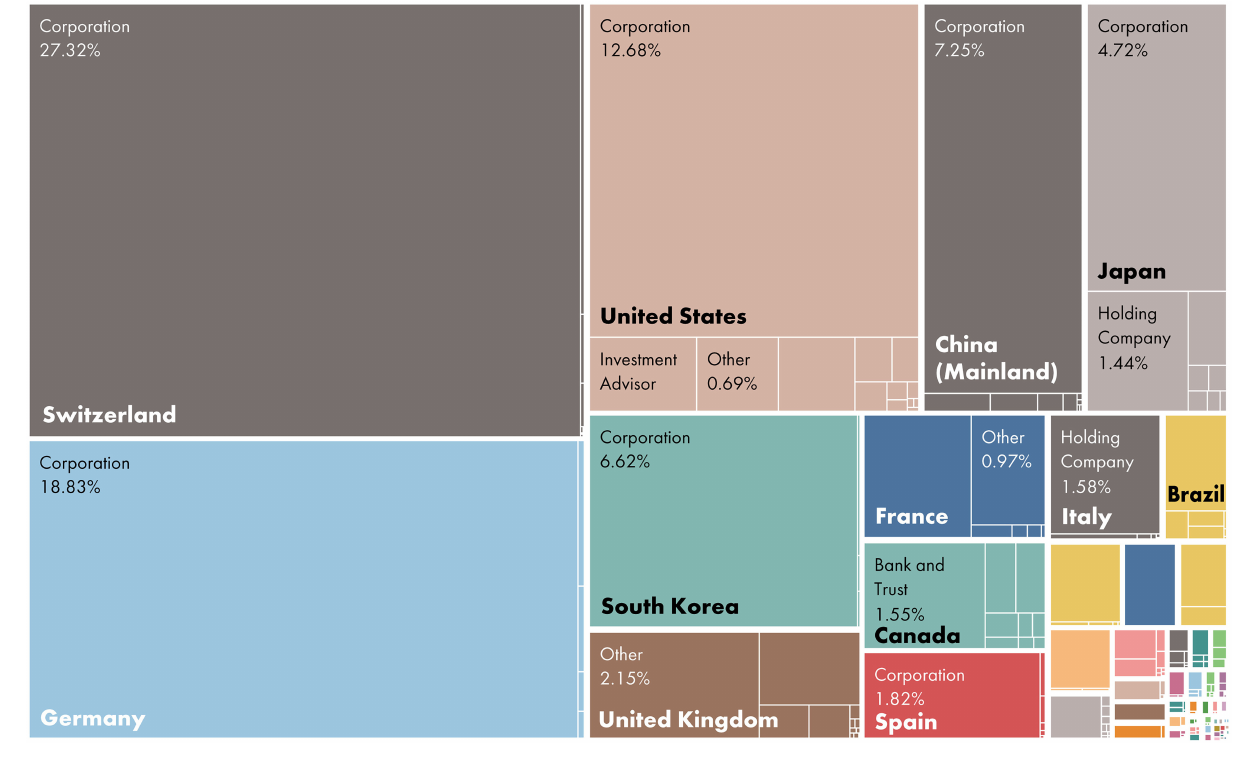
FIGURE 3 | Total ultimate ESG ownership by